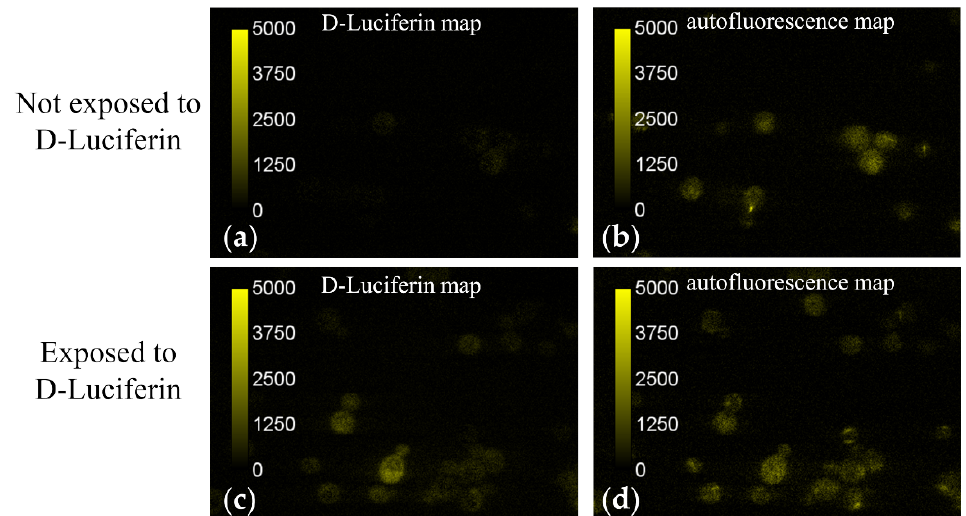
Figure 5. Fluorescence intensity maps of D-Luciferin and autofluorescence signal obtained by unmixing microspectroscopic images of yeast cells before ( a , b ) and after ( c , d ) exposure to the naturally fluorescent molecule D-luciferin. Intensities are assigned false colors according to their value and a correlation scale is given as an inset. ( a , b ) A representative field of view obtained from yeast cells prior to exposure to D-Luciferin is shown for both the unmixed ( a ) D-Luciferin and ( b ) autofluorescence intensity maps. A D-Luciferin component was used in the unmixing, even for the cells not exposed to D-Luciferin, in order to establish a noise baseline for detecting D-Luciferin signal. The mean pixel intensities of the D-Luciferin and autofluorescence signals (n = 148 cells) were 36 ± 153 and 1000 ± 351 counts, respectively. ( c , d ) The yeast cells were suspended in a 250 μ M solution of D-luciferin for 25 min. The cell/D-luciferin suspension was then centrifuged and washed with 1 mL 100 mM KCl three times before resuspending in 100 μ L of 100 mM KCl. The mean pixel intensities of the D-Luciferin and autofluorescence signals (n = 154 cells) were 455 ± 250 and 723 ± 319 counts, respectively. Because the average D-Luciferin signal was larger than the baseline value established for cells not exposed to D-Luciferin, it was determined that there was a small amount of pinocytosis of the D-Luciferin molecules occurring.